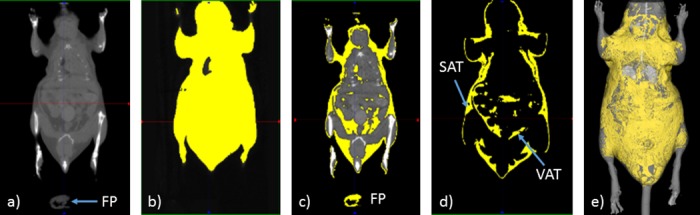
The different steps for quantification of total adipose tissue by micro-computed tomography.Anesthetized mice are placed in a supine position in an imaging cell; three-dimensional x-ray images are acquired on the CT part of a μSPECT-μCT (eXplore speCZT Vision 120, GE, Waukesha, USA). Volumes are reconstructed with a voxel size equal to 100x100x100 μm3; reconstructed images are filtered with a Gaussian filter to reduce noise. (a) Whole body scan. (b) Selection of whole body volume. (c) Choice of threshold level based on fat pad (FP). (d) Representation of total adipose tissue with subcutaneous adipose tissue (SAT) and visceral adipose tissue (VAT). (e) Isosurface representation of whole body in grey and fat in yellow.